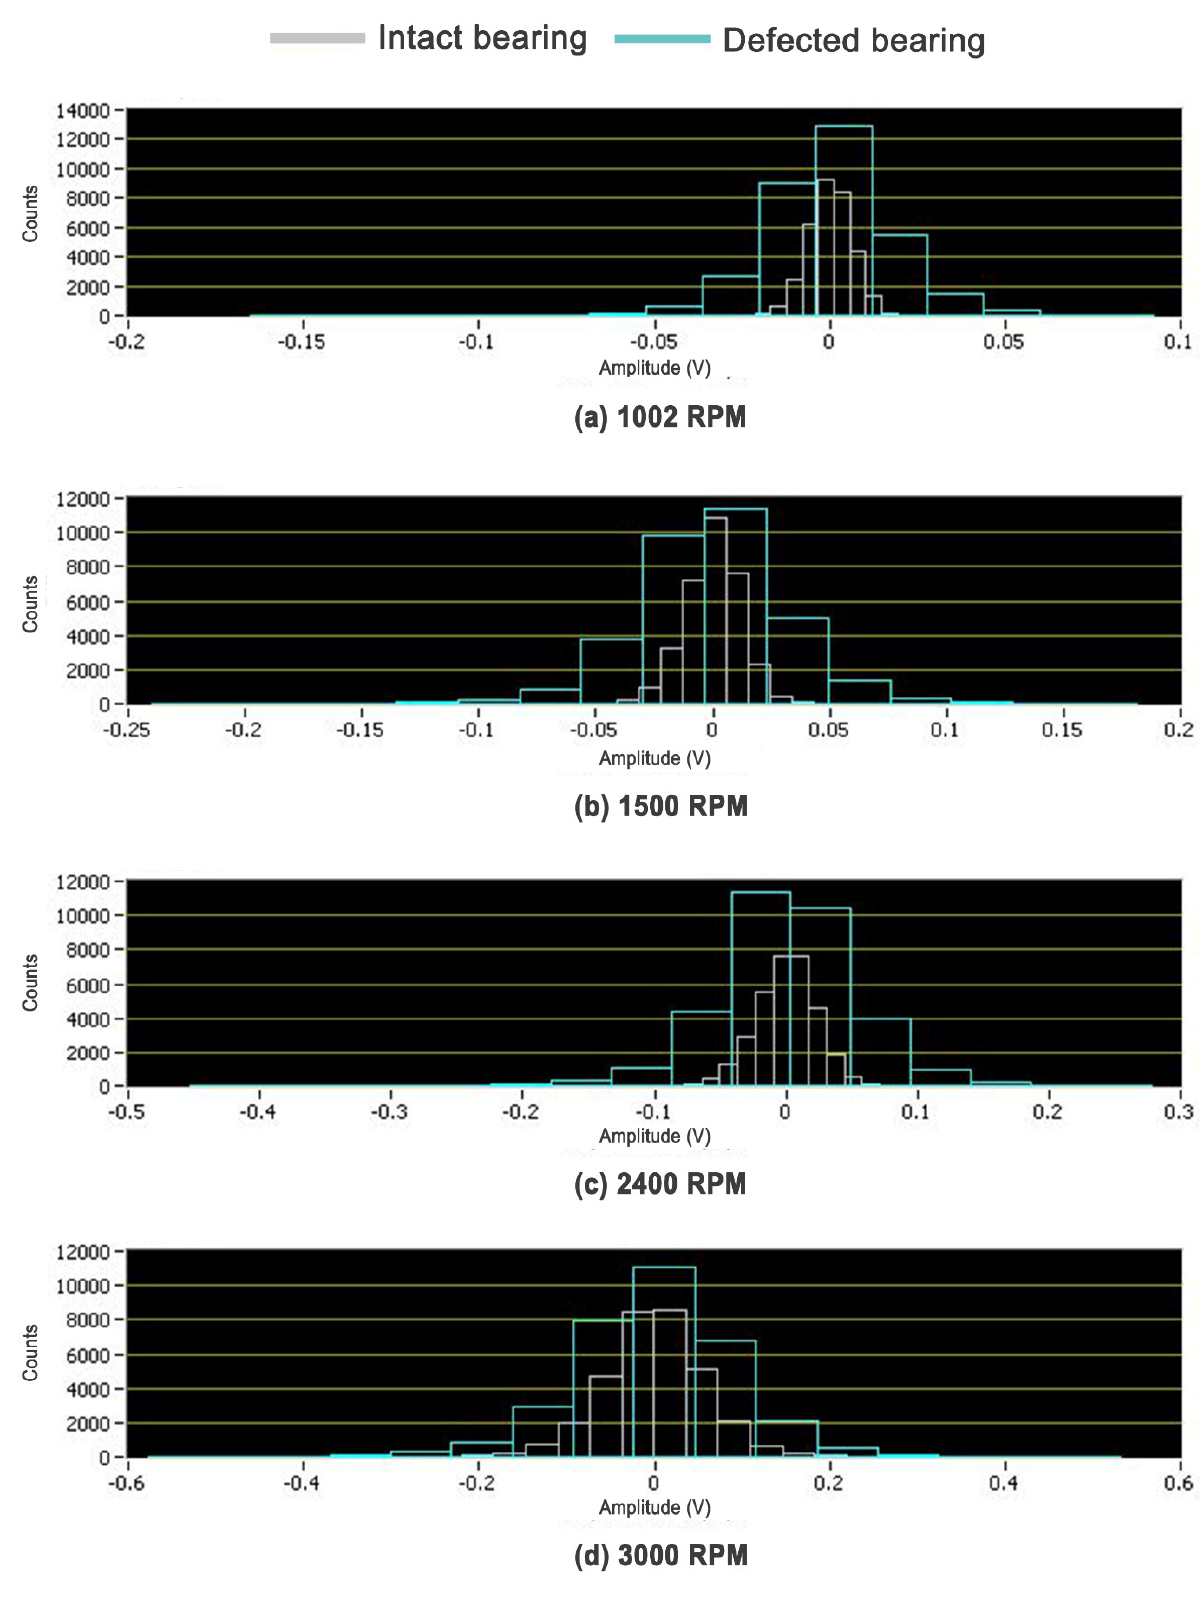
Figure 5. Histograms for an outer race damage with installing a bearing loader.